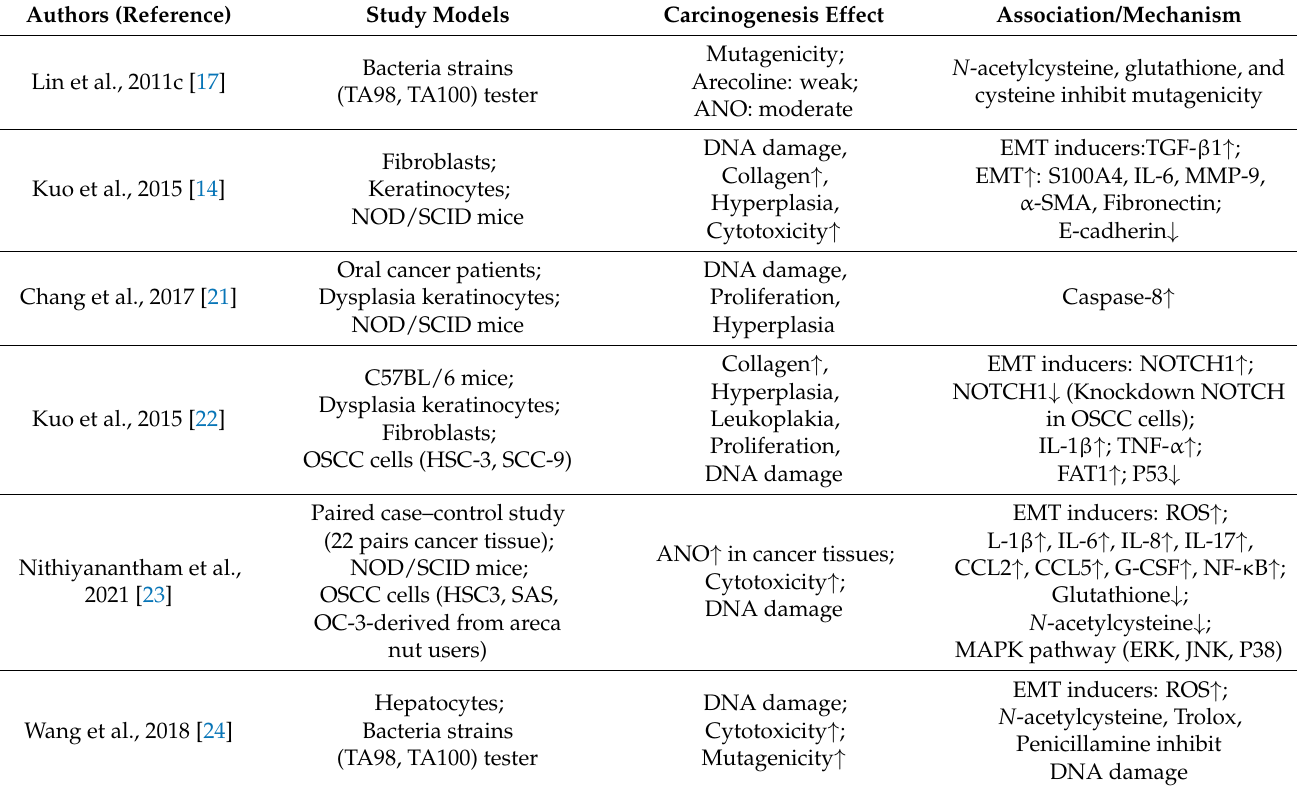
Table 1. Role of arecoline N -oxide (ANO) in